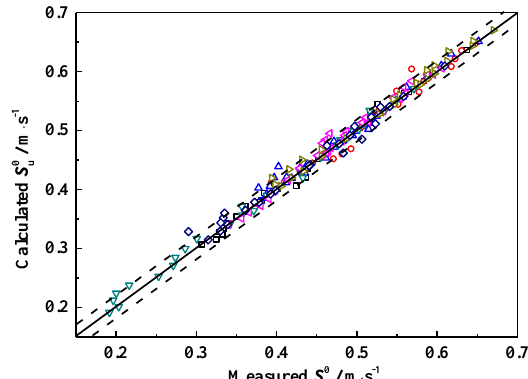
Figure 14. The measured laminar flame speeds in literatures [27–29,51] vs. the calculated values with Equation (8) at various initial conditions.